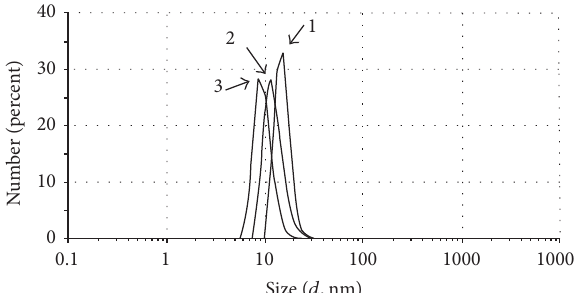
Figure 2: Particle size distributions obtained by QLS from latexes samples from copolymerizations of MMA/MAA (2/1, mol/mol) at different global conversions: (1) 13.9%, (2) 36.7%, and (3)